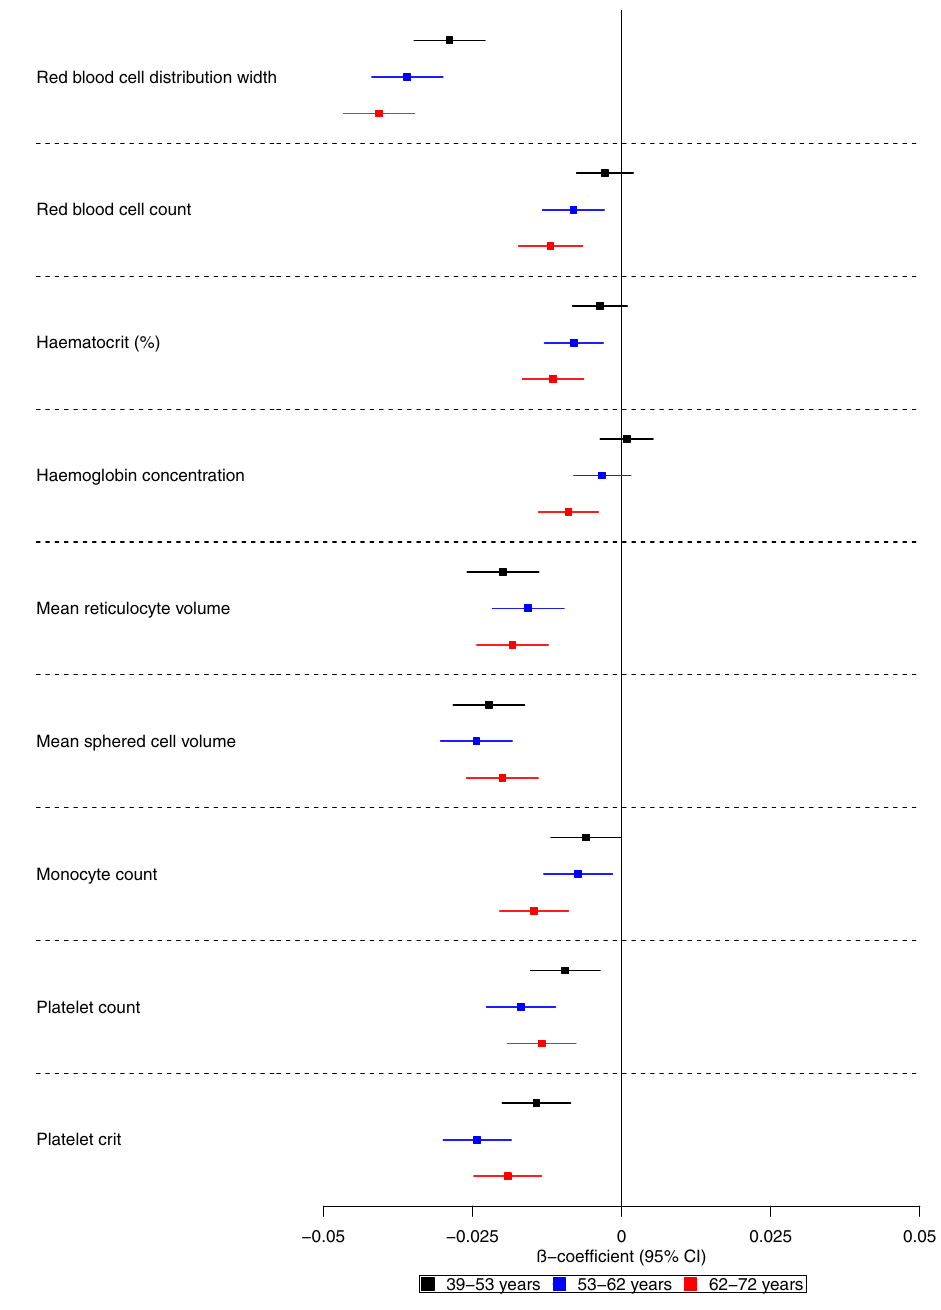
score for Alzheimer ’ s disease. Error bars represent 95% con fi dence intervals.